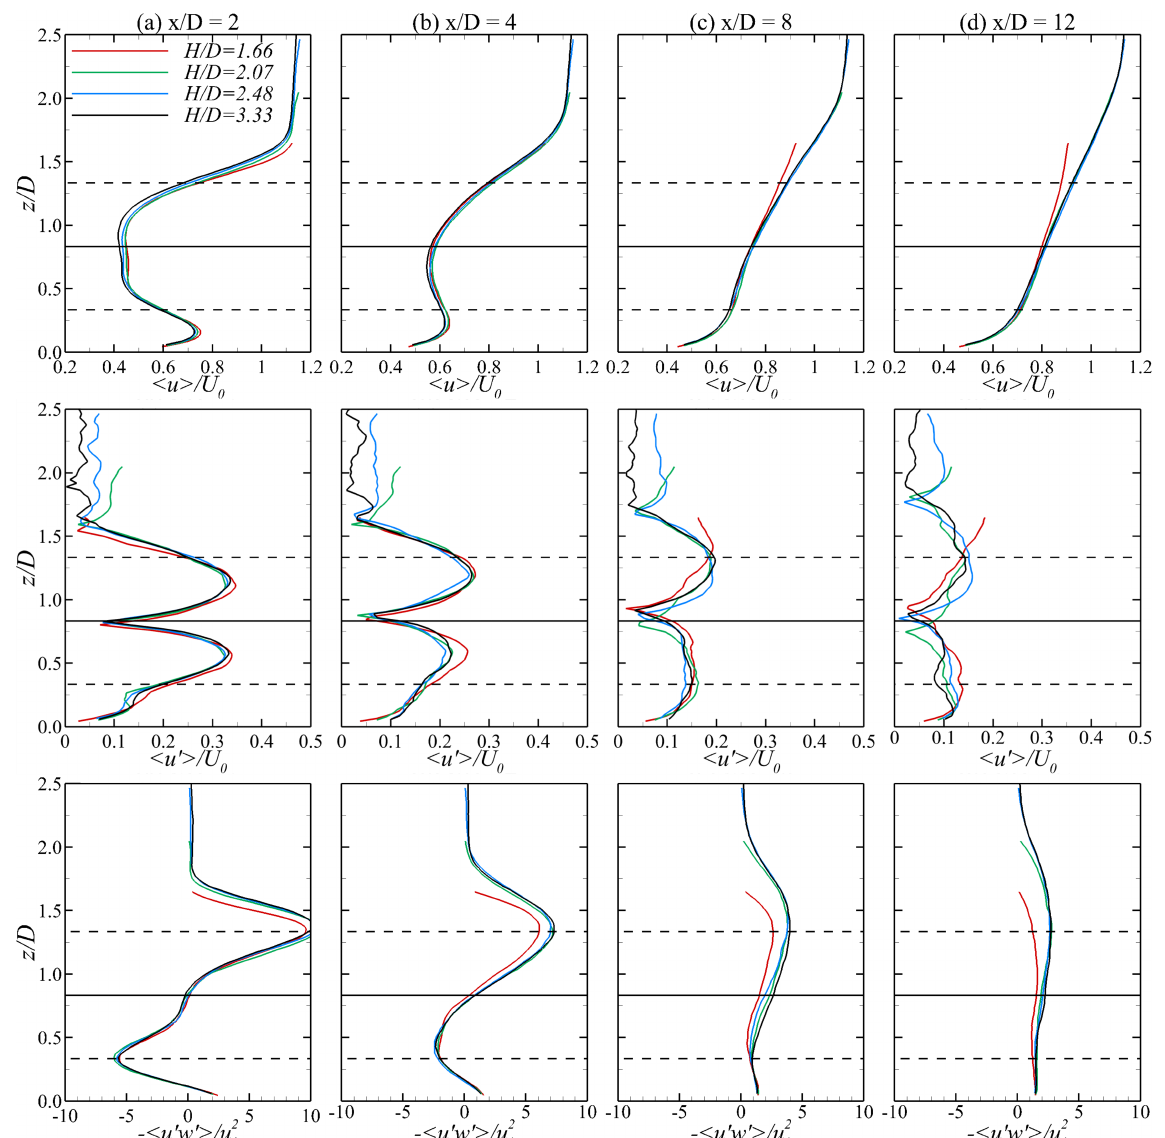
Fig. 3. Vertical distribution of mean (a) streamwise velocities, (b) turbulence intensity and (c) vertical Reynolds shear stresses for the four submergence cases. Results are averaged over the lateral wake region indicated in Figure